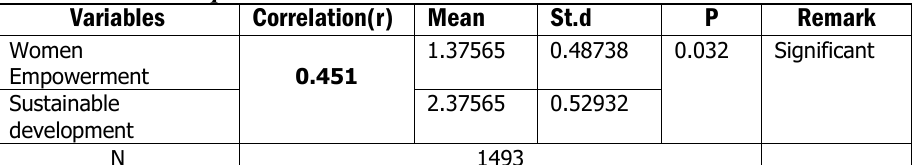
Table 7 Correlation analysis of Women Empowerment Programs and Sustainable